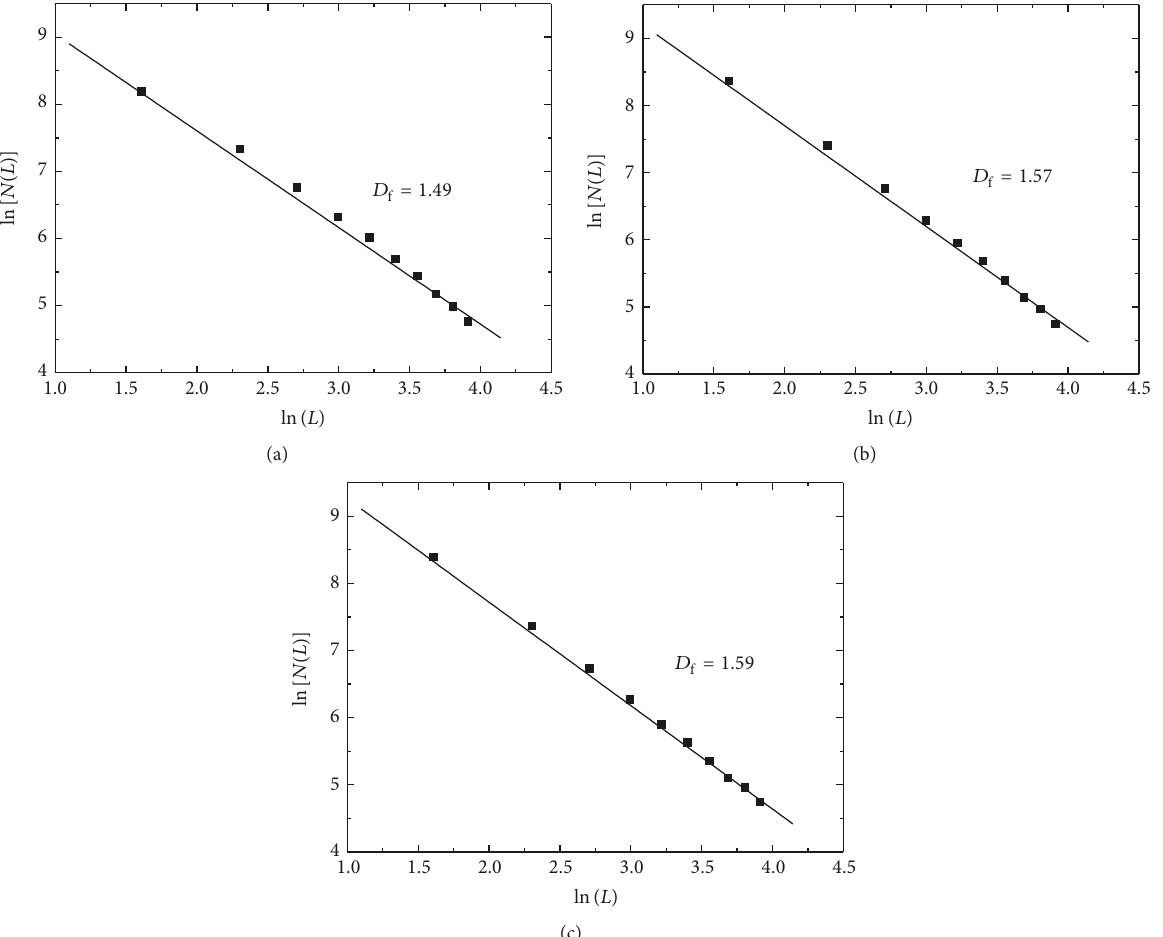
Figure 9: The calculated results of the pore area fractal dimension 𝐷 f for the PFMM samples.